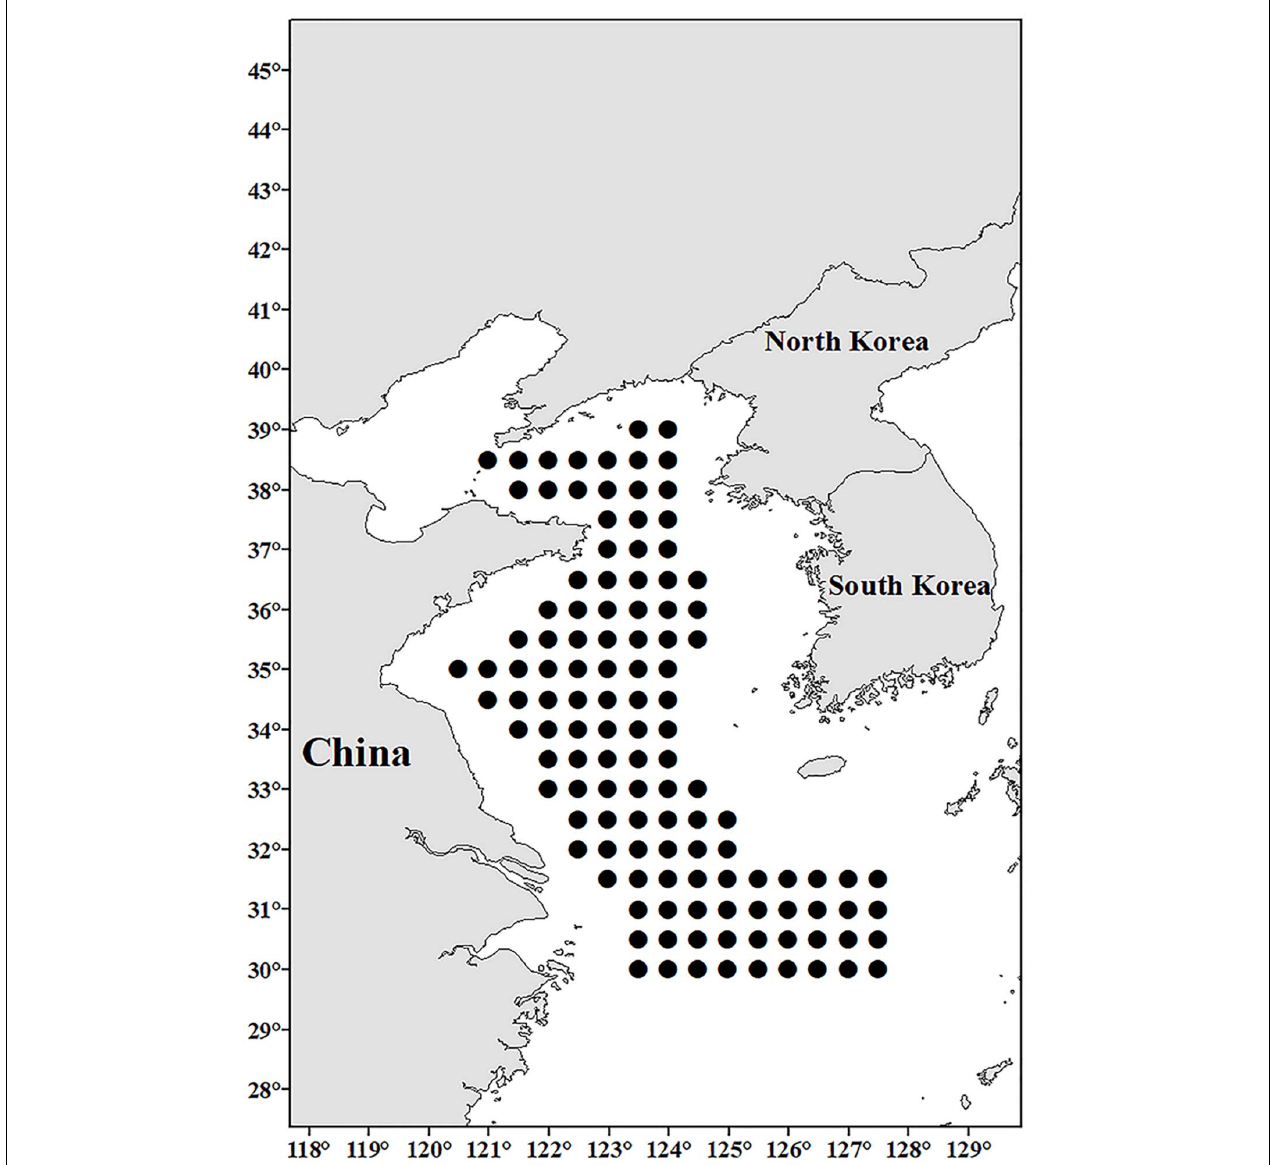
FIGURE 1 | The designated sampling sites (black dots) in the Yellow Sea and northern East China Sea in the